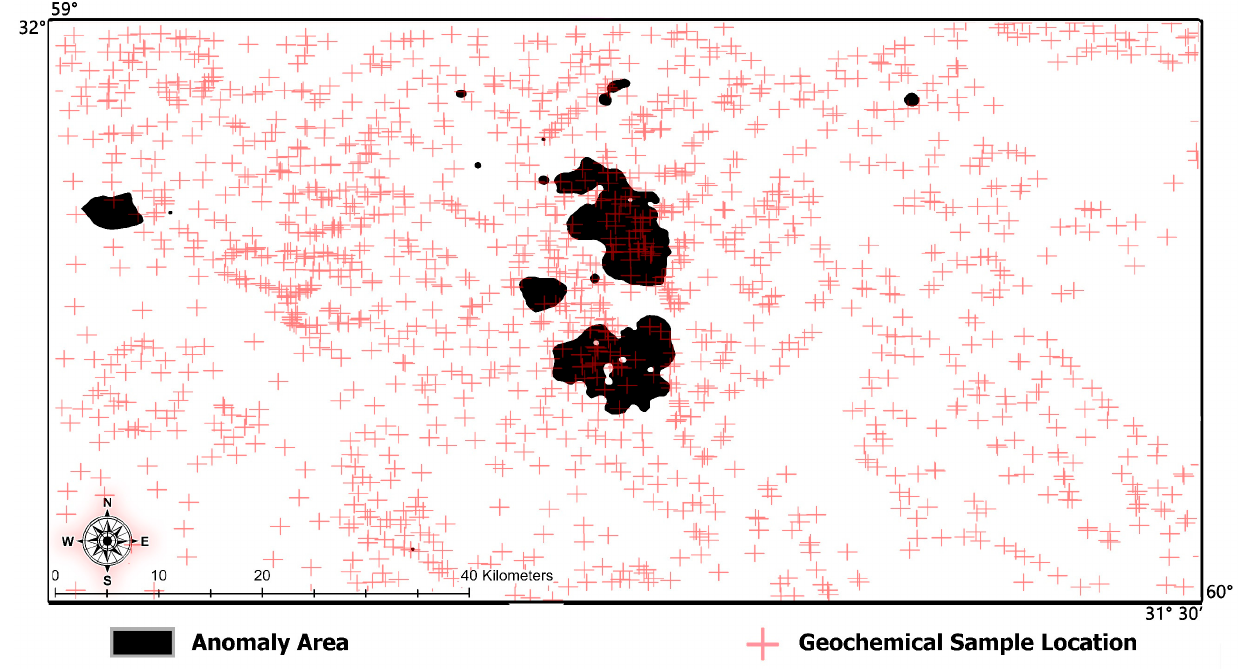
Figure 16. The prospectivity map of supra-mineral elements based on stream sediment samples.